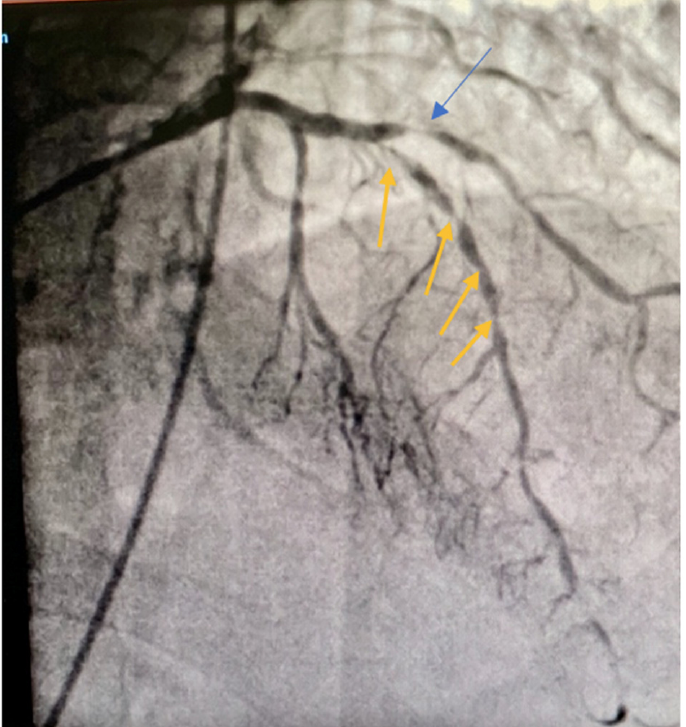
Figure 1. Diffusely diseased LAD artery with multiple severe distal stenosis (orange arrows) and proximal severe stenosis on the diagonal branch (blue arrow).